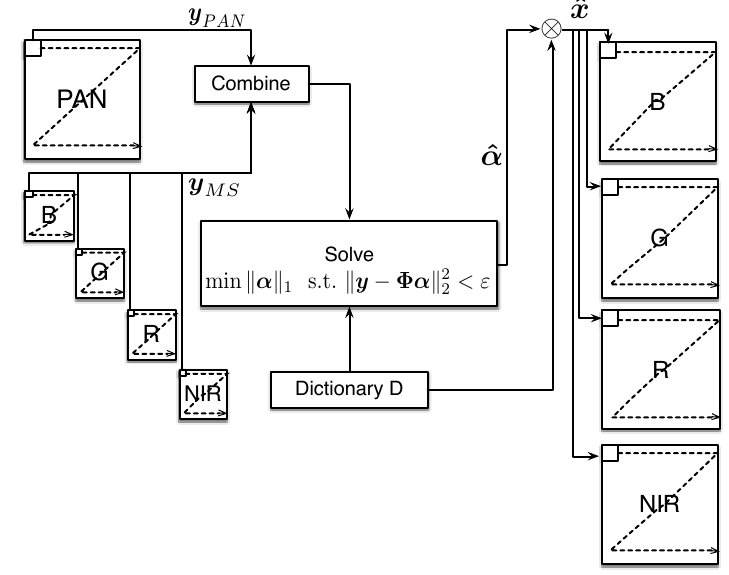
Figure 1. Flowchart of a pan-sharpening algorithm based on compressed sensing